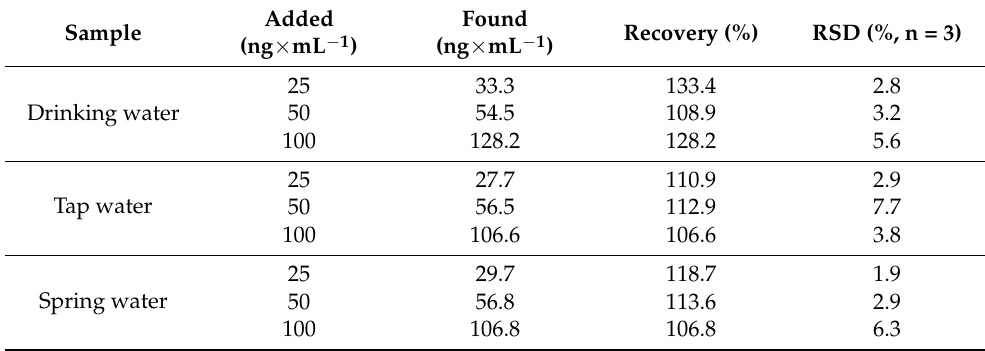
Table 3. Colorimetric detection of Pb 2+ in spiked water